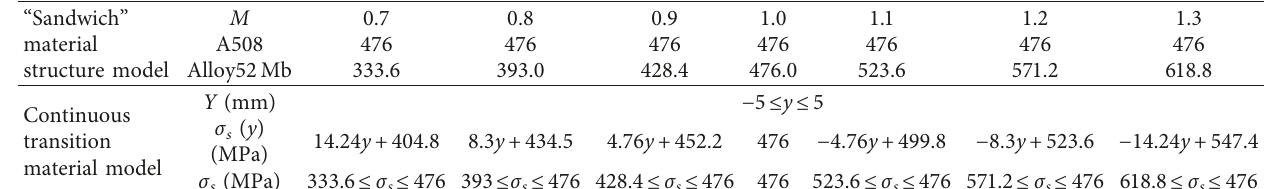
Figure 8: CT sample size schematic diagram. Table 1: Material properties and mismatch coefficient of welded